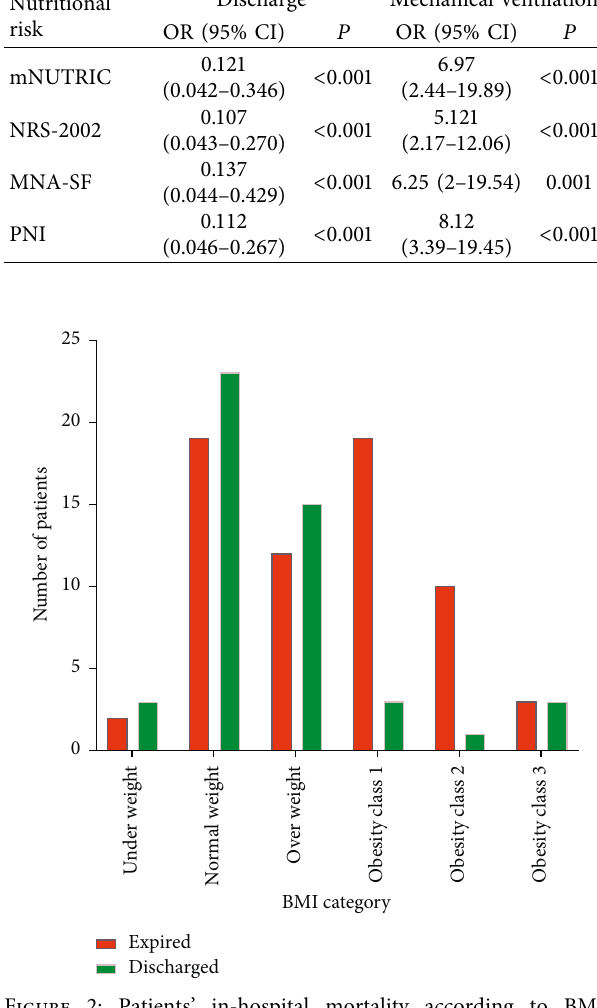
Figure 2: Patients’ in-hospital mortality according to BMI categories.